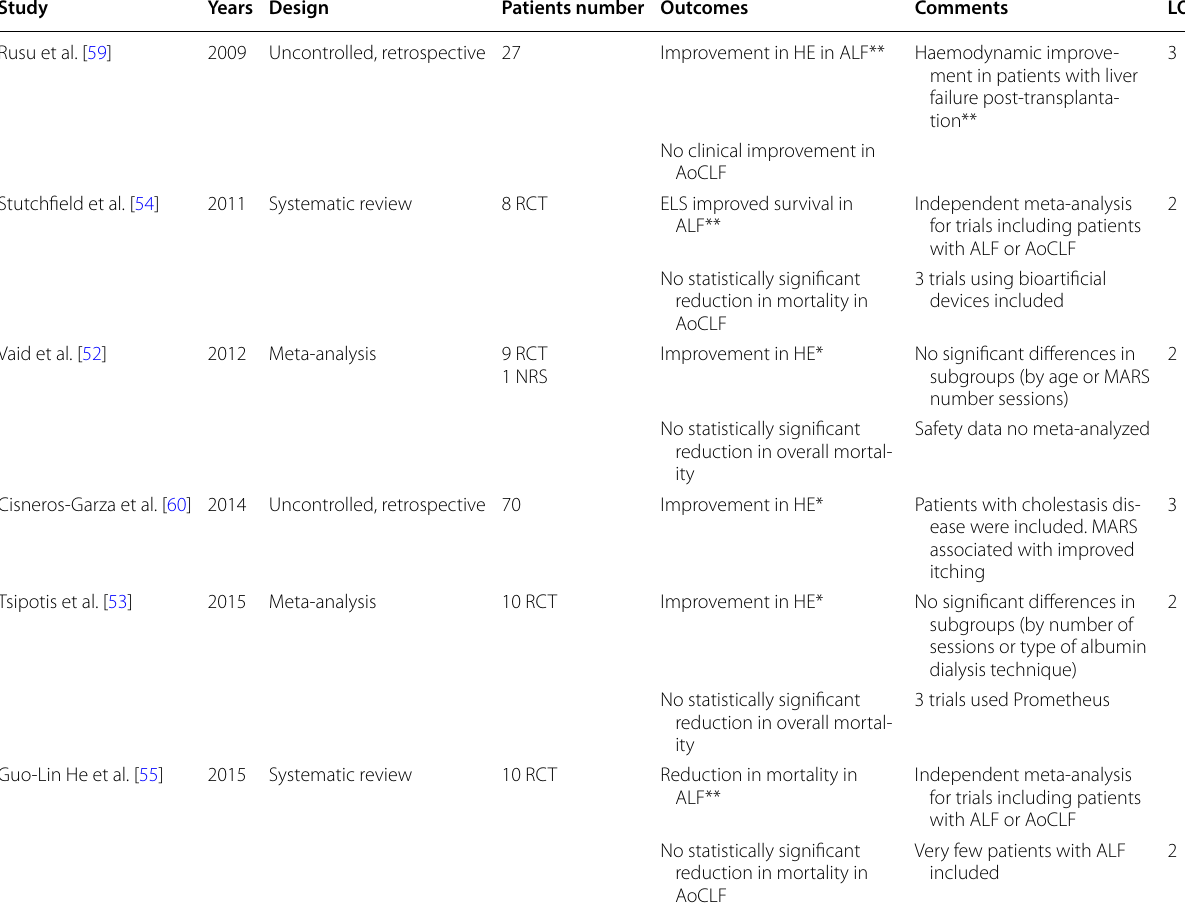
Table 3 Studies with clinical endpoints for ALF and AoCLF combined using